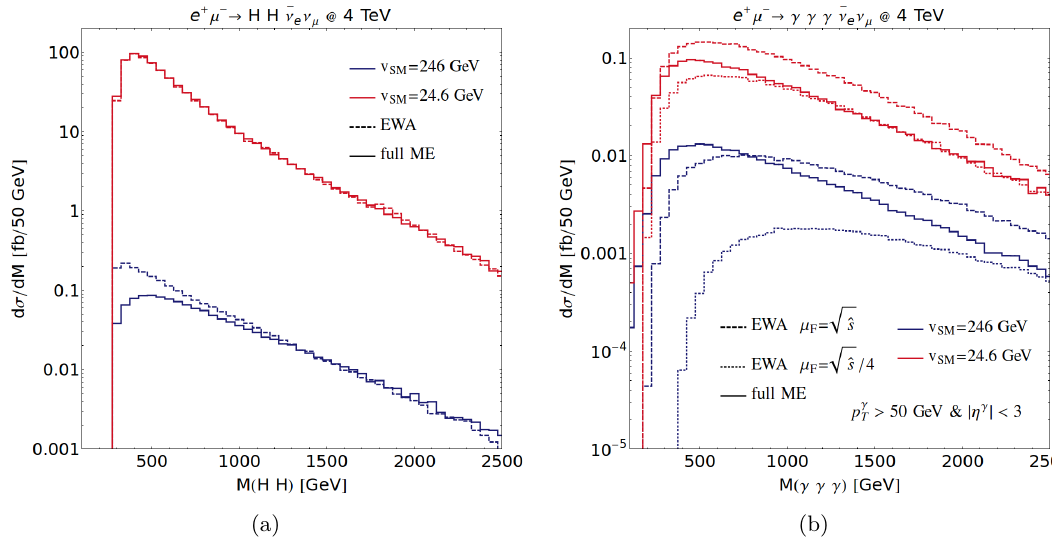
Figure 2 . (a) The invariant mass distribution M ( HH ) of the process W + W − → HH , as predicted √ by the full 2 → 4 ME (solid) and the EWA W + W − → HH ME (dash) at s = 4 TeV , assuming √ √ 0 0 the SM vev 2 h Φ i = v 246 GeV (darker, lower curves) and a scenario where 2 h Φ i = v 10 SM ≈ SM / (lighter, upper curves). (b) Same but for the M ( γγγ ) distribution of the process W + W − → γγγ , assuming the fiducial cuts in eq. (4.4), and for the W + W − → γγγ ME in the EWA with µ f = M ( γγγ ) T T (dash) and µ = M ( γγγ ) / 4 f